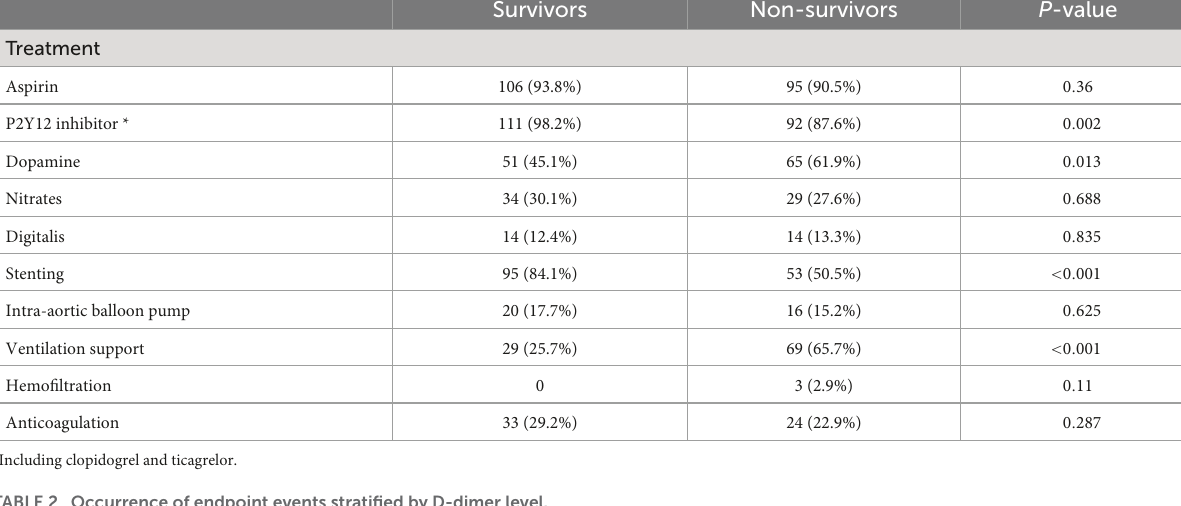
TABLE 2 Occurrence of endpoint events stratified by D-dimer level.